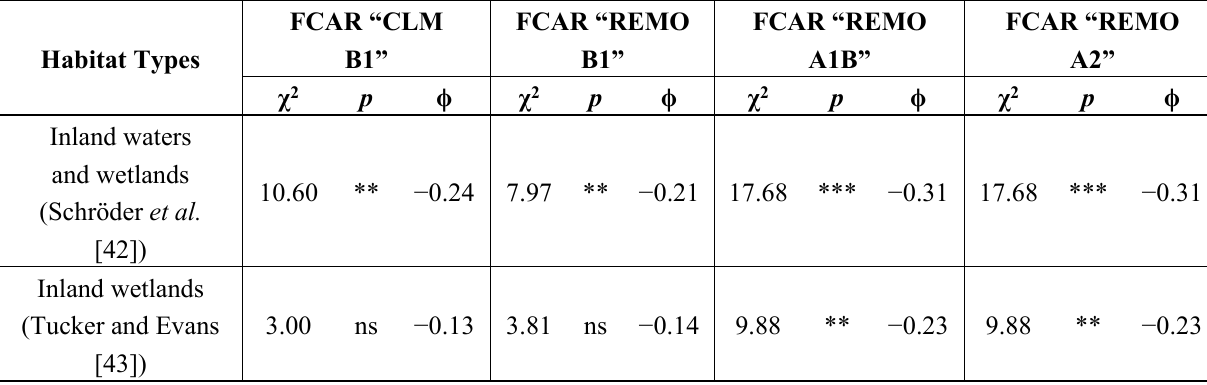
Table 7. Significant negative associations between the degree of conformity of the results of the FCAR approach and of Huntley et al. [18] for the LHR (future presence/absence) and habitat types ( n = 184, df =